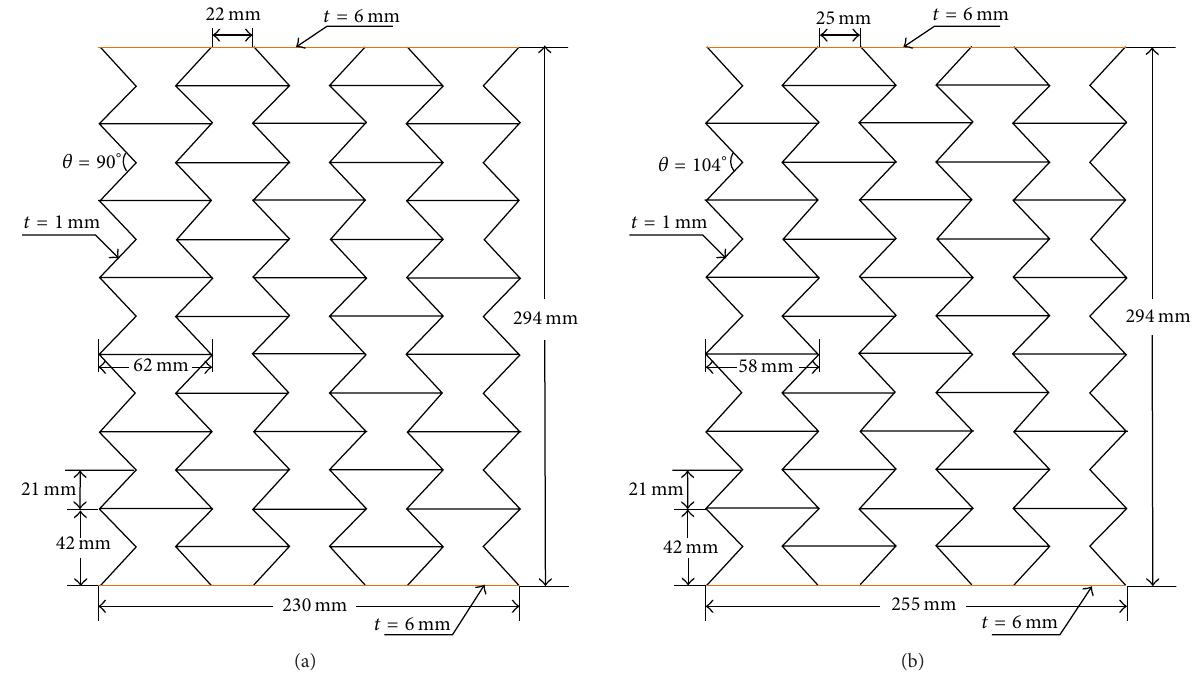
Figure 12: Geometry of two test bases: (a) the control base and (b) the verification